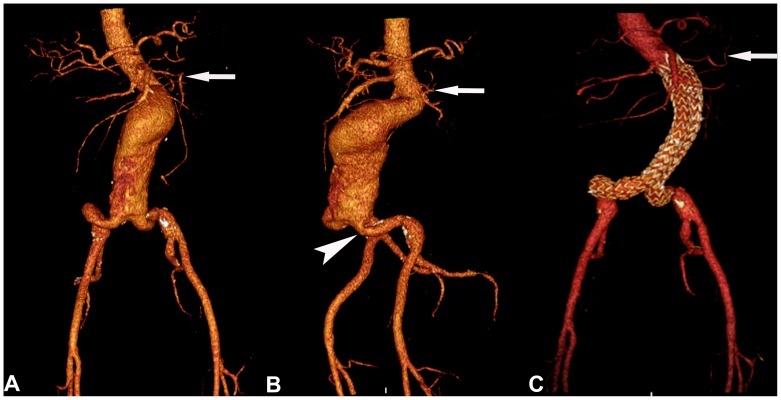
CTA of an infrarenal AAA in a 74-year-old patient. A,VR of the long aneurysm with a short proximal neck. The aneurysm involves the aortic bifurcation, and there is marked angulation of the infrarenal portion (arrow indicates the left renal artery). Both common iliac arteries are markedly elongated. B, Lateral VR more clearly showing the elongation of the left common iliac artery and also severe kinking (arrowhead) at its origin as well as marked infrarenal angulation of the proximal neck (arrow indicates the left renal artery). C, Postinterventional VR indicating successful implantation of an Endurant stent graft and exclusion of AAA (arrow indicates the left renal artery).